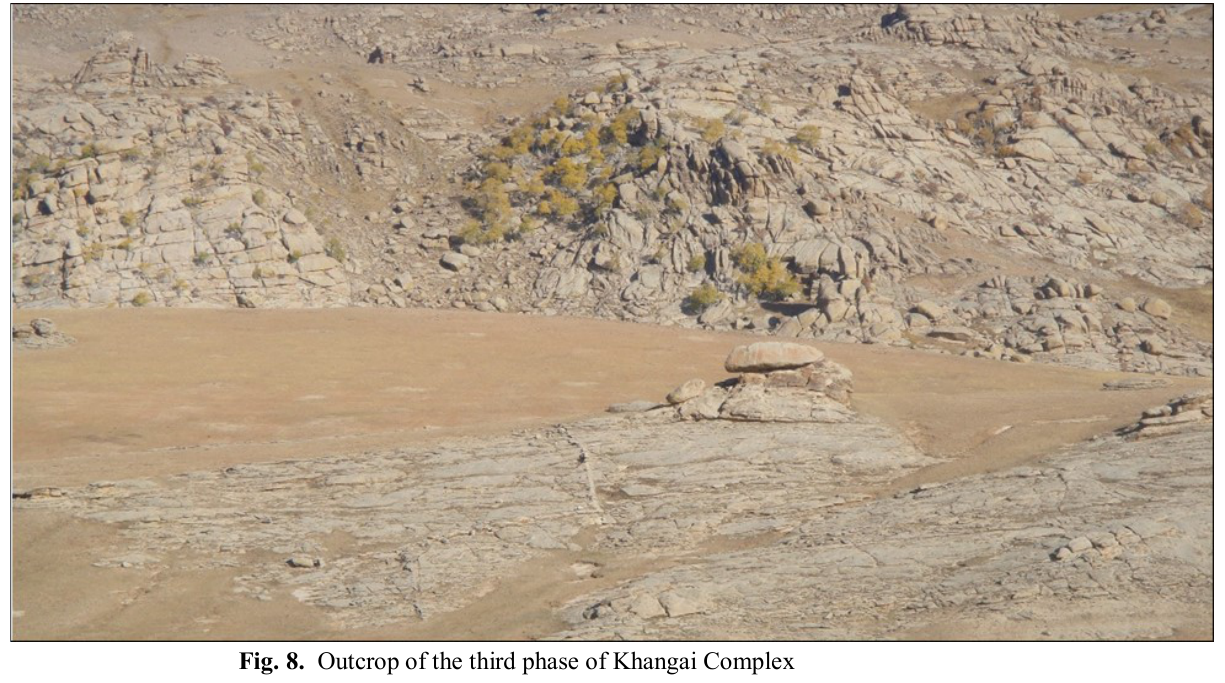
Fig. 8. Outcrop of the third phase of Khangai